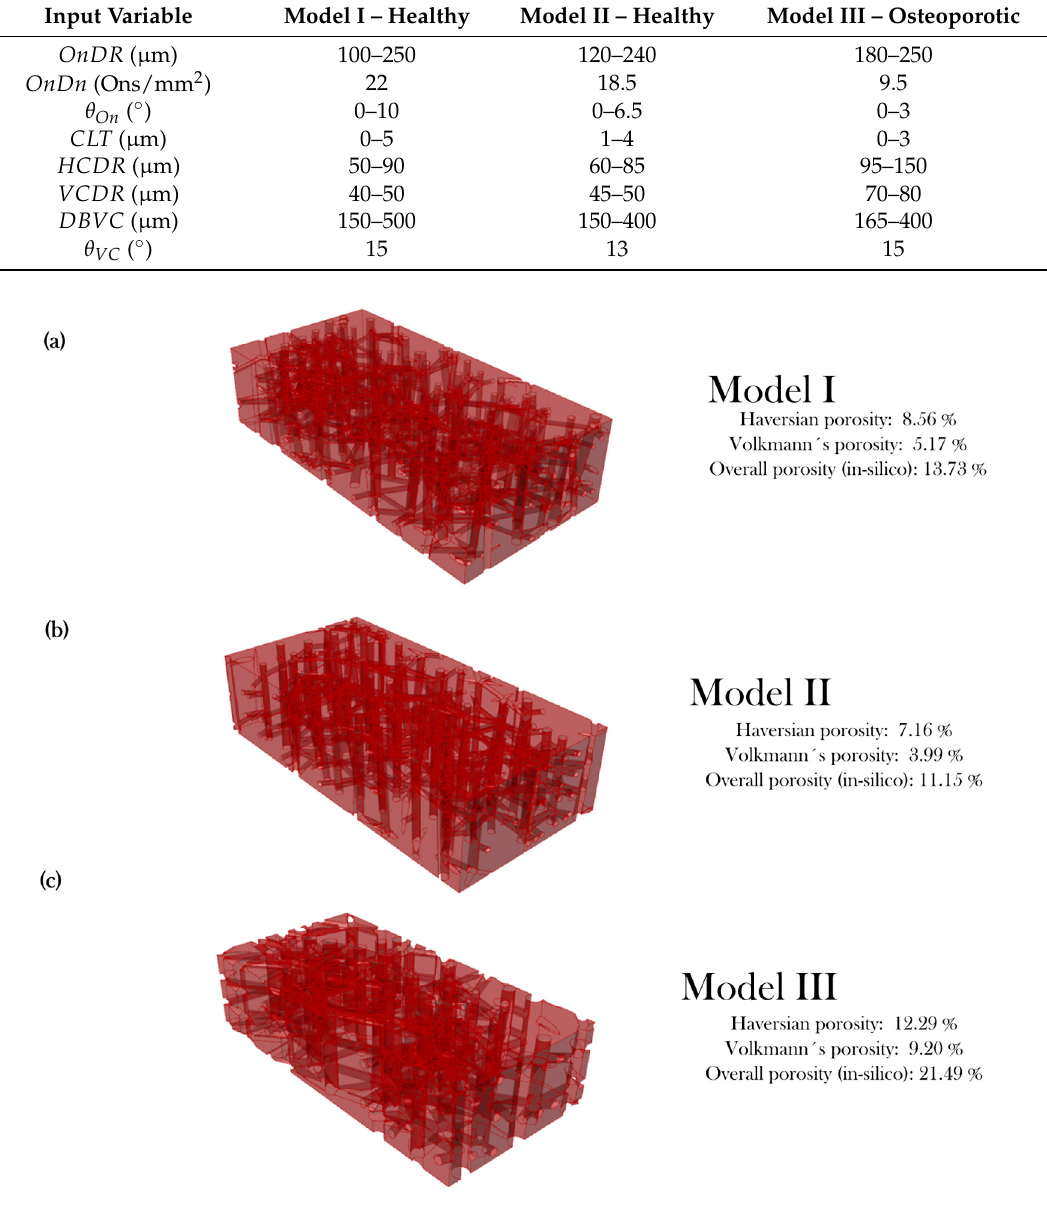
Figure 4. Models and porosity of the models used for algorithm validation. ( a ) Model I (healthy) exhibited a haversian porosity of 8.56%, Volkmann’s porosity of 5.17% and overall porosity of 13.73%, which is within limits of healthy bone structure. ( b ) Model II (healthy) exhibited a haversian porosity of 7.16%, Volkmann’s porosity of 3.99% and overall porosity of 11.15%, which is within limits of healthy bone structure. ( c ) Model III (osteoporotic) successfully exhibited out-of-range values in all porosities due to the out-of-range input values.